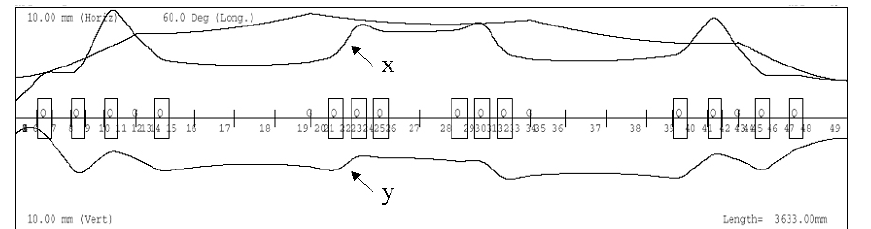
FIG. 6. Trace 3D beam envelope profiles of modified MEBT to reduce the beam eccentricity.